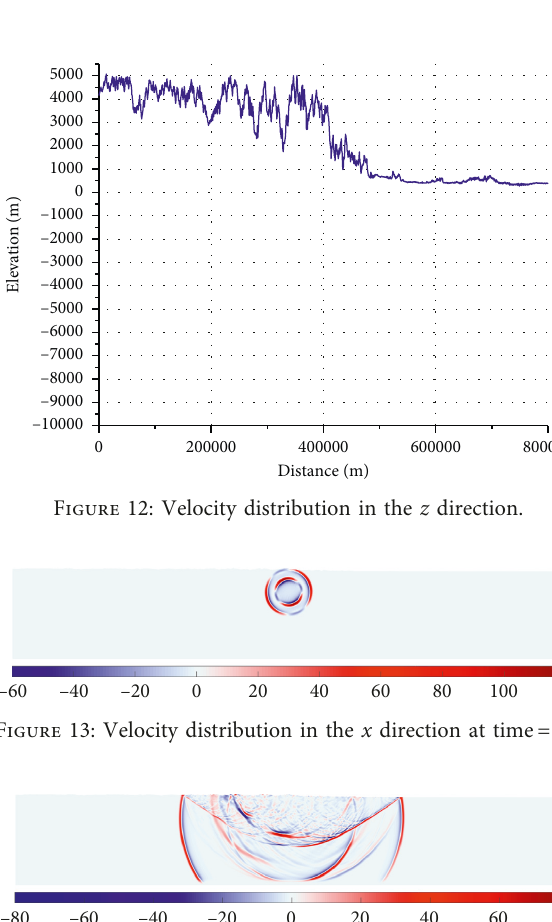
Figure 11: Velocity distribution in the z direction (a) at time � 0.6s, (b) at time � 1.0 s, (c) at time � 1.4 s, (d) at time � 1.8s, (e) at time � 2.4s, and (f) at time � 3.0s.